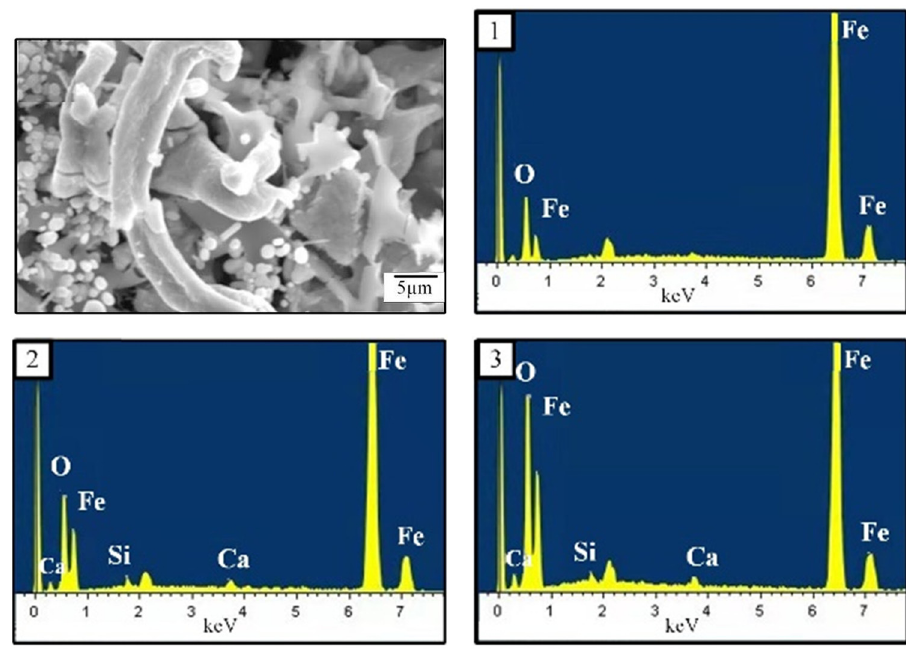
Figure 13: EDS image of briquettes reduced for 60 min ( basicity = 0.83 ) .